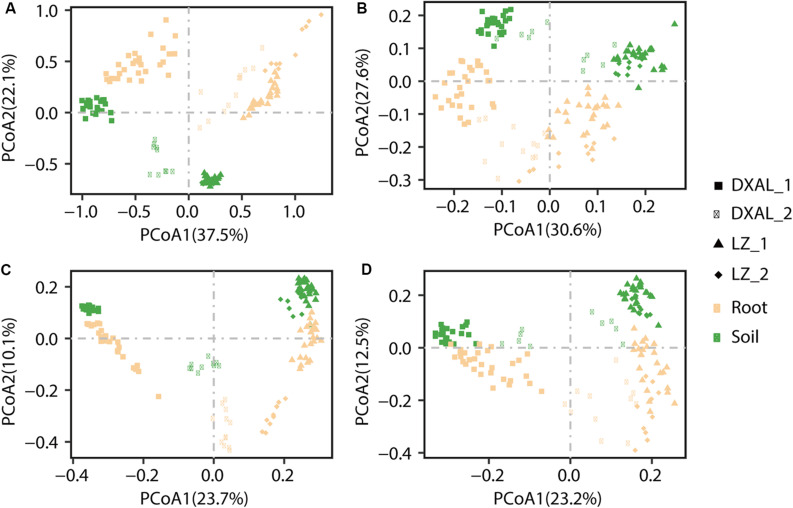
PCoA of microbial community composition among different sample types of G. conopsea. (A) PCoA using the WUF distances at the OTU level using fungal community’s data. (B) PCoA using the UUF distances at the OTU level using fungal community’s data. (C) PCoA using the WUF distances at the OTU level using bacterial community’s data. (D) PCoA using the UUF distances at the OTU level using bacterial community’s data. Samples are color coded according to the sites, compartments, and developmental stages are depicted with different symbols. DXAL: Greater Khingan Mountains, LZ: Linzhi, 1: vegetative growth stage, 2: reproductive growth stage.